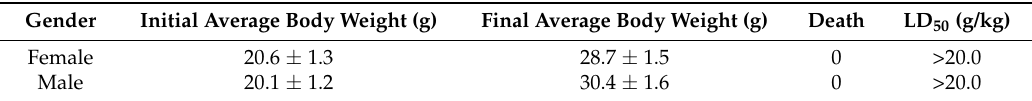
Table 5. Acute oral toxicity of